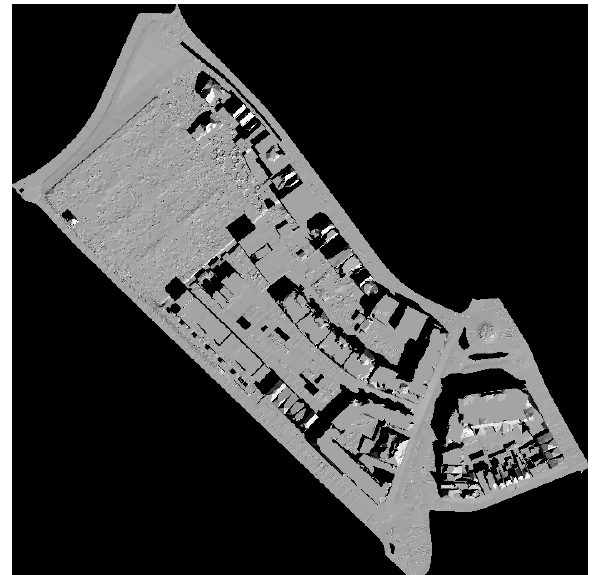
Figure 8: Simulated shade and shadow 2010